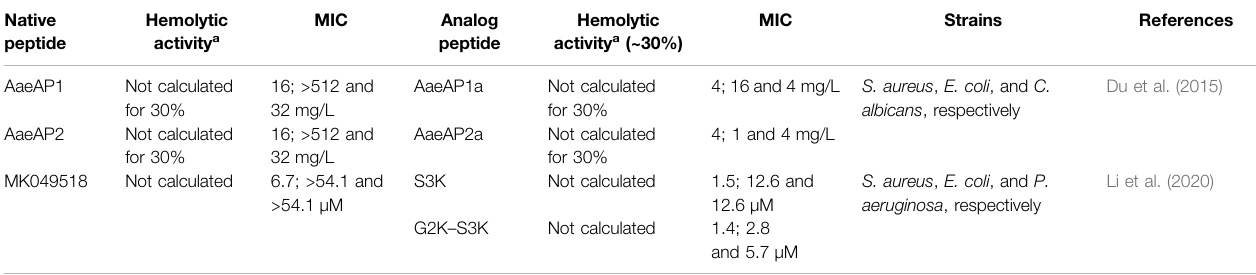
TABLE 2 | ( Continued ) Comparison of hemolytic and antimicrobial activities of native scorpion peptides and their analogs after modi fi